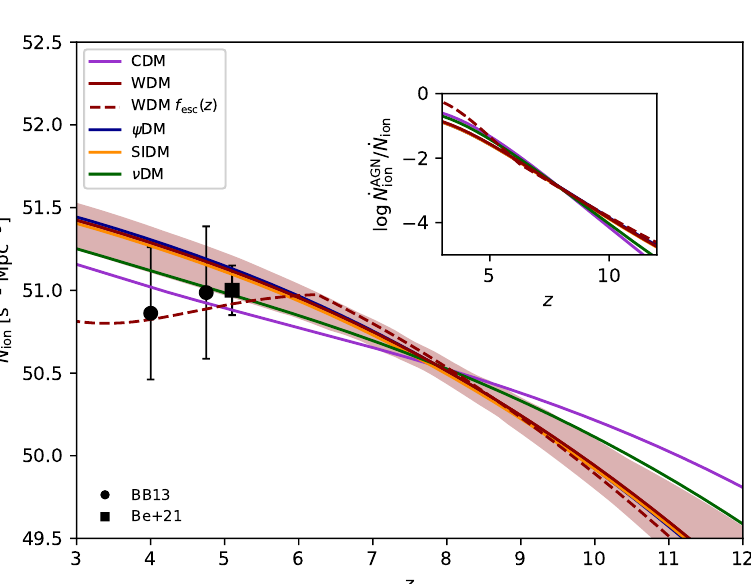
Figure 11. The ionizing photon rate as a function of redshift. Data are from [116] (circles) and [117] (squares). Lines as in Figure 10. The inset illustrates the contribution of AGNs (see Equation (3)) to the total ionizing photon rate as a function of redshift, in the various DM